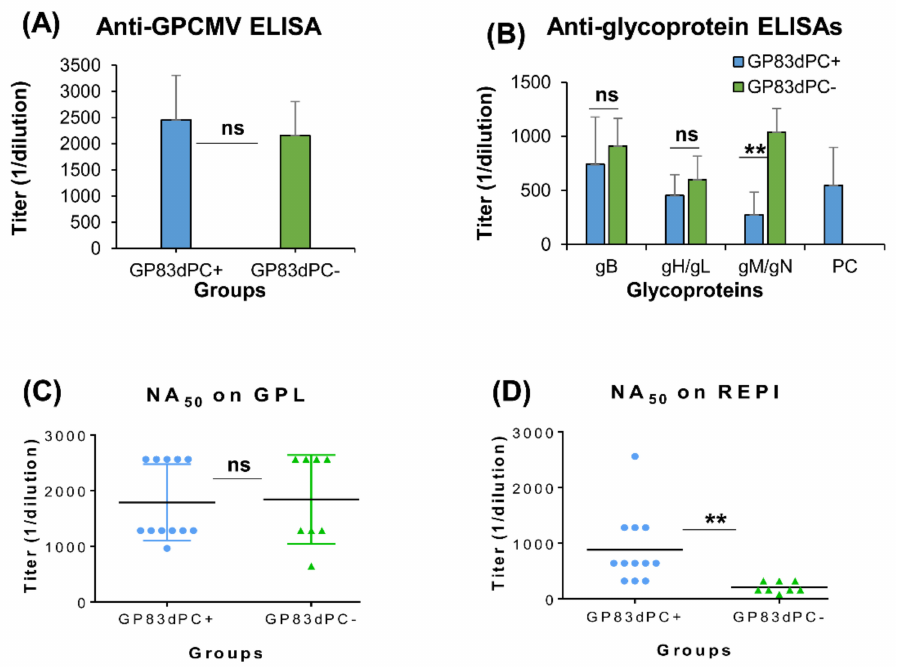
Figure 3. Comparative immune response of animals inoculated with GP83dPC+ vs. GP83dPC − vaccine. ( A ) Mean anti-GPCMV titer comparison of D45 sera from animals inoculated with GP83dPC+ ( n = 12; blue) or GP83dPC − ( n = 8; green). ( B ) Comparative mean anti-glycoprotein complex ELISA titers (gB, gH/gL, gM/gN, PC) from sera in animals inoculated with GP83dPC+ (blue) or GP83dPC − vaccine (green). Comparative GPCMV neutralization (NA 50 ) on GPL cells ( C ) or REPI epithelial cells ( D ) of individual serum from vaccinated animals from both groups: GP83dPC+ vaccinated (blue); GP83dPC − vaccinated (green). Black solid line represents mean titer. Mean ELISA and neutralization values are a result of assay triplicates with each sample run minimum of three independent